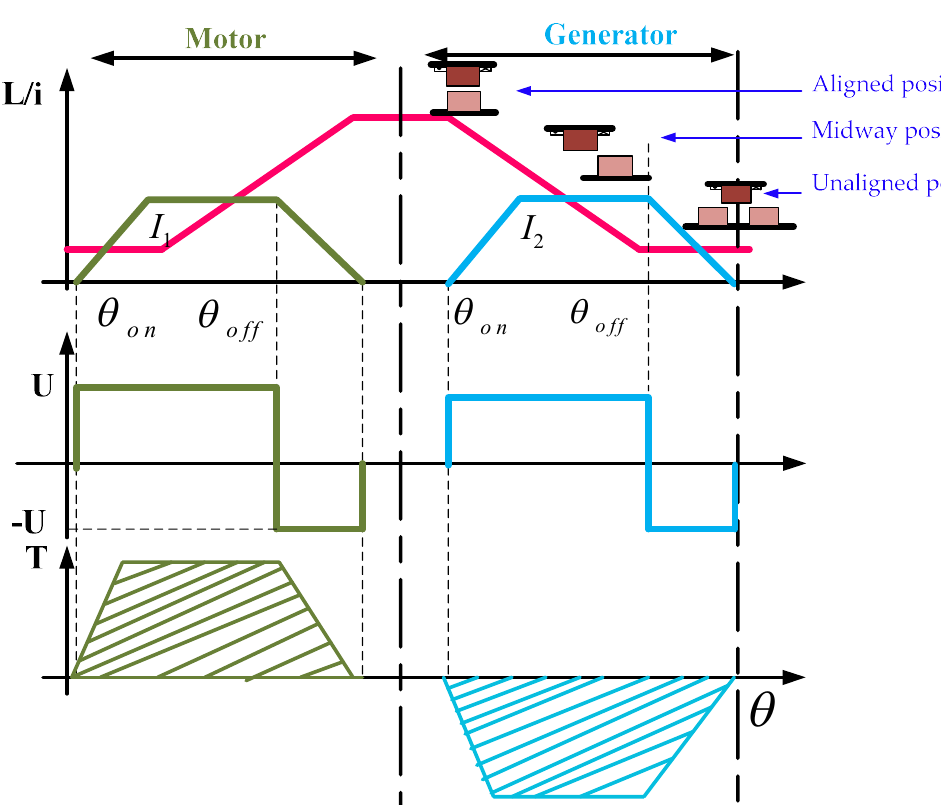
Figure 5. Inductance, voltage, and torque profile of one of the SRG phases.